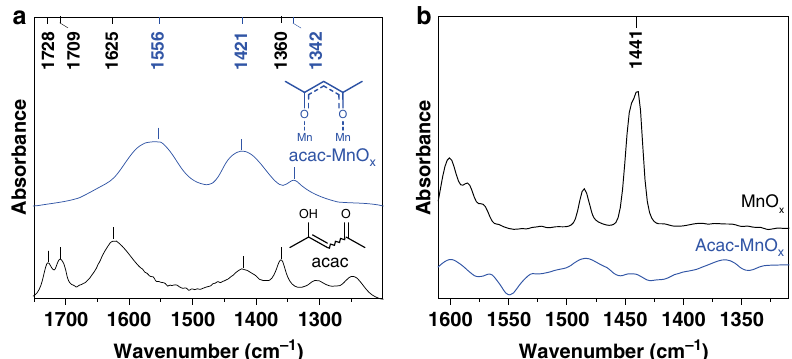
Fig. 2 Catalyst characterization. a FT-IR spectra of acac and acac-MnO x after evacuation at 150 °C for 0.5 h. b FT-IR spectra of pyridine adsorption to MnO x and acac-MnO x